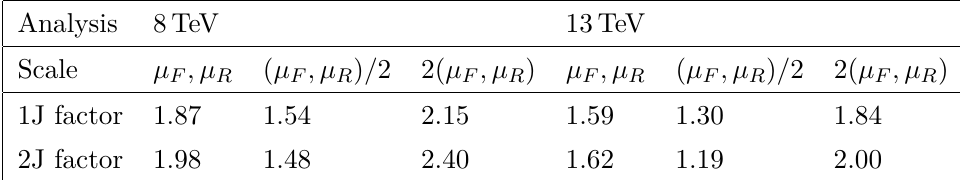
Table 5. NLO Reweighting factors with µ F = µ R = max( m 12 , m H )